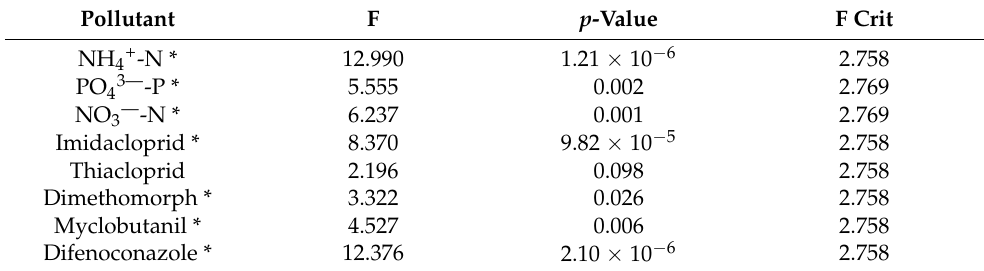
Table 5. Results of ANOVA test performed between the four experimental tanks, that is, azola, water hyacinth, Lemna minor and control tank, for each of the examined